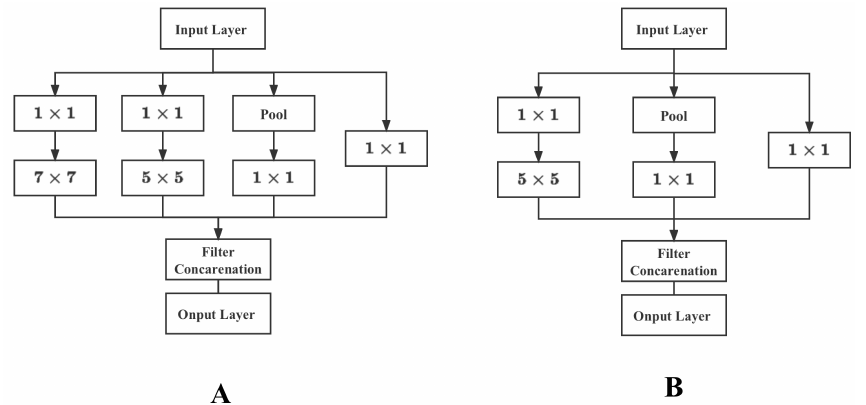
Figure 9. Modified inception module ( A ) and module ( B ).